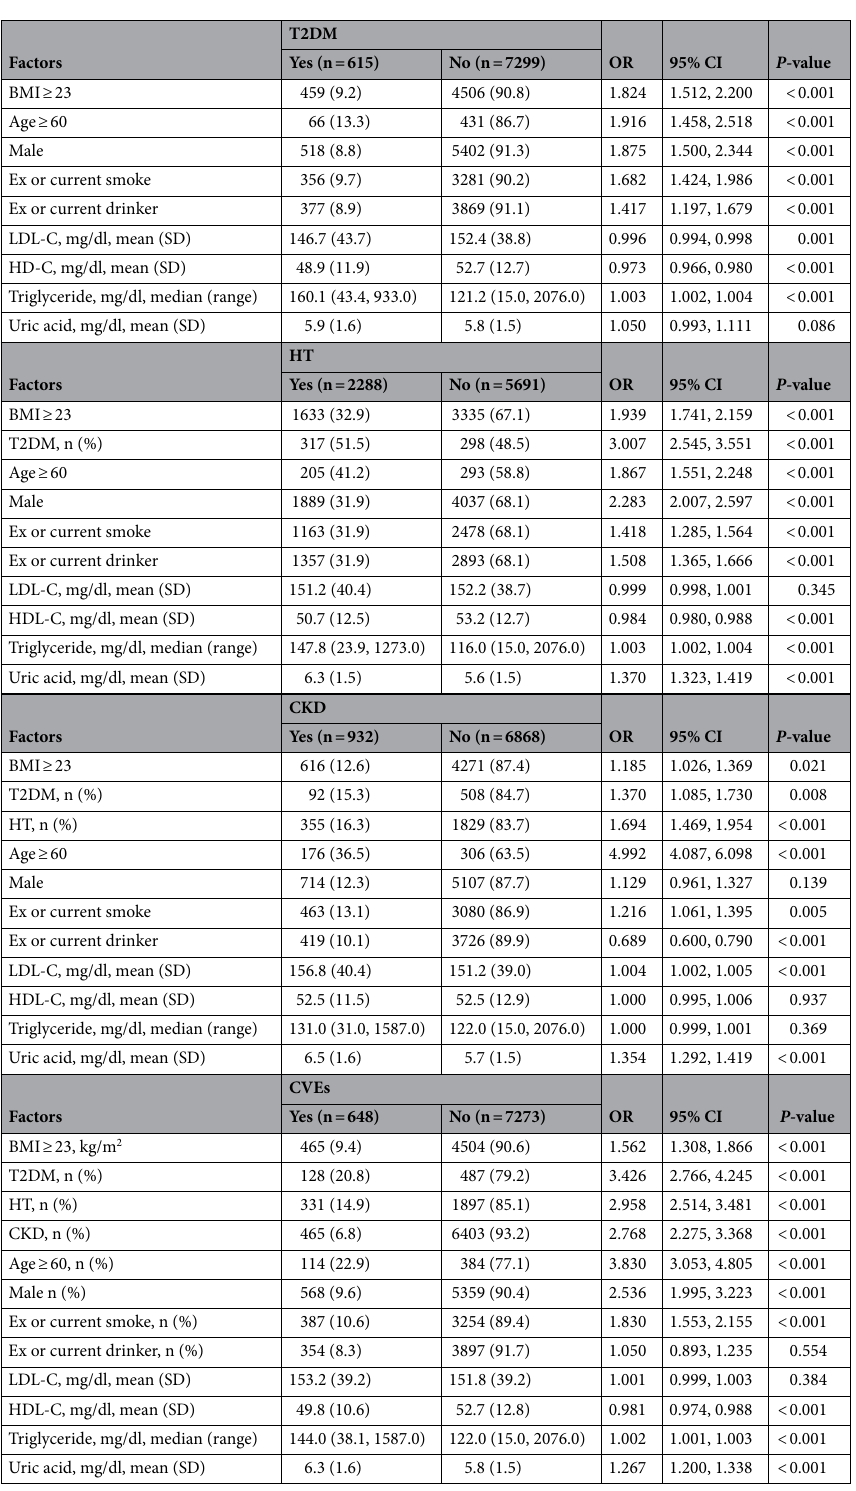
Table 3. Factors associated with diabetes mellitus, hypertension, chronic kidney disease and cardiovascular events: univariate logistic regression. Abbreviations as in Table